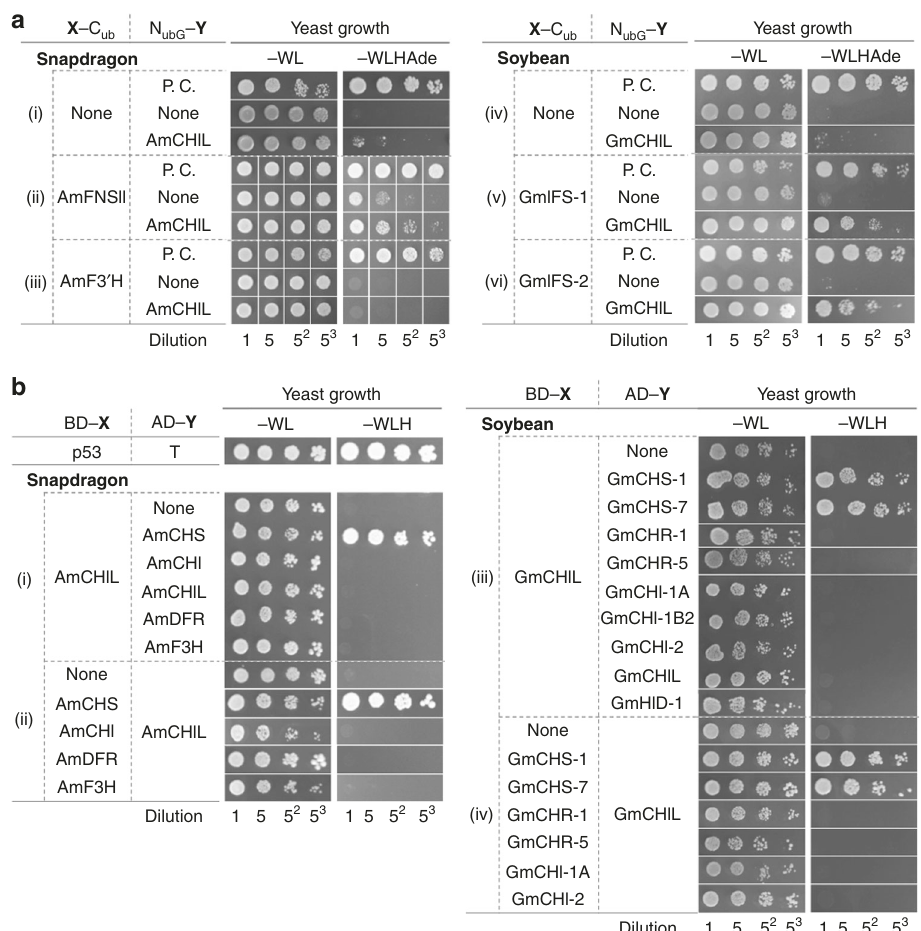
Fig. 2 Interactions between CHIL and fl avonoid enzymes in snapdragon and soybean as determined in yeast assay systems. a Interactions between CHIL and cytochromes P450 in snapdragon (i – iii) and soybean (iv – vi) were analyzed with the split-ubiquitin yeast two-hybrid systems. Regarding the protein names, the initials of the scienti fi c name of plant species are followed by the abbreviated enzyme/protein names, with homologs indicated with a hyphen. For example, GmCHS-1 refers to isozyme 1 of a soybean ( Glycine max ) CHS. (i – iii) Growth of yeast cells co-expressing X-C ub -LexA-VP16 with N ubG -AmCHIL, where X refers to (i) nothing, (ii) fl avone synthase II (AmFNSII), and (iii) fl avonoid 3 ′ -hydroxylase (AmF3 ′ H). (iv – vi) Growth of yeast cells co-expressing X-C ub -LexA-VP16 with N ubG -GmCHIL, where X refers to (iv) nothing, (v) isozyme 1 of 2-hydroxyiso fl avanone synthase (GmIFS-1), and (vi) isozyme 2 of GmIFS (GmIFS-2). In the N ubG -Y column of each panel, P.C. refers to the positive control [transformed cells harboring pOst1-NubI (a plasmid expressing a fusion protein comprising the yeast resident ER protein Ost1 and the wild-type N ub portion of yeast ubiquitin) and derivatives of pBT3-SUC]. “ None ” refers to the negative control (transformed cells harboring the empty pPR3-N vector and derivatives of pBT3-SUC). b Interactions between CHIL and soluble fl avonoid enzymes in (i, ii) snapdragon and (iii, iv) soybean were analyzed with GAL4-based yeast two-hybrid systems. The growth of yeast cells co-expressing CHIL and fl avonoid enzymes as fusions with the activation domain (AD, AD-Y column) and the DNA-binding domain (BD, BD-X column) of the yeast GAL4 transcription factor is presented. (i) BD-AmCHIL was co-expressed with AD-Y, where Y refers to CHS (AmCHS), CHI (AmCHI), AmCHIL, dihydro fl avonol 4-reductase (AmDFR), or fl avanone 3-hydroxylase (AmF3H). “ None ” refers to yeast cells co-expressing AD (without a fused protein) and BD-AmCHIL. (ii) AD-AmCHIL was co-expressed with BD-X, where X refers to AmCHS, AmCHI, AmDFR, or AmF3H. “ None ” refers to yeast cells co-expressing BD (without a fused protein) and AD-AmCHIL. (iii) BD-GmCHIL was co-expressed with AD-Y, where Y refers to CHS isozymes (GmCHS-1 and GmCHS-7), chalcone reductase (CHR) isozymes (GmCHR-1 and GmCHR-5), CHI isozymes (GmCHI-1A, GmCHI-1B2, and GmCHI-2), GmCHIL, or a 2-hydroxyiso fl avanone dehydratase isozyme (GmHID-1). “ None ” refers to yeast cells co-expressing AD (without a fused protein) and BD- GmCHIL. (iv) AD-GmCHIL was co-expressed with BD-X, where X refers to GmCHS-1, GmCHS-7, GmCHR-1, GmCHR-5, GmCHI-1A, or GmCHI-2. “ None ” refers to yeast cells co-expressing BD (without a fused protein) and AD-GmCHIL. Abbreviated growth media names are as follows: − WL, SD agar medium lacking tryptophan and leucine; − WLH, − WL medium lacking histidine; − WLHAde, − WLH medium lacking